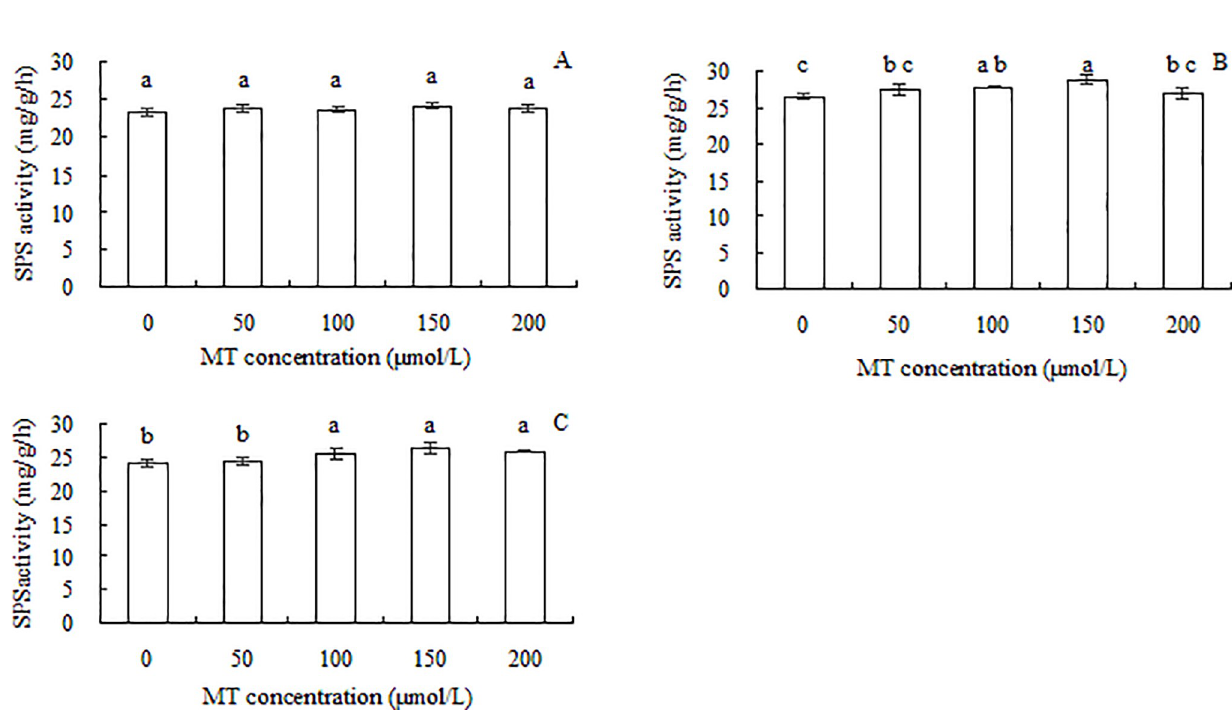
Fig 5. Sucrose phosphate synthase (SPS) activities in roots (A), stems (B), and leaves (C) of grape seedlings. Different lowercase letters indicate significant differences based on one-way analysis of variance followed by least significant difference test ( p � 0.05).